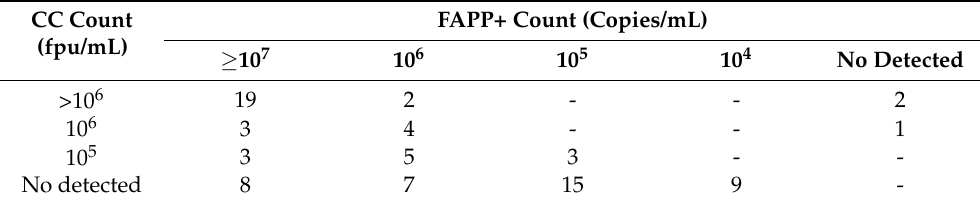
Table 4. Comparison of the microbiological count of pathogens detected by the FAPP+ and CC. CC Count